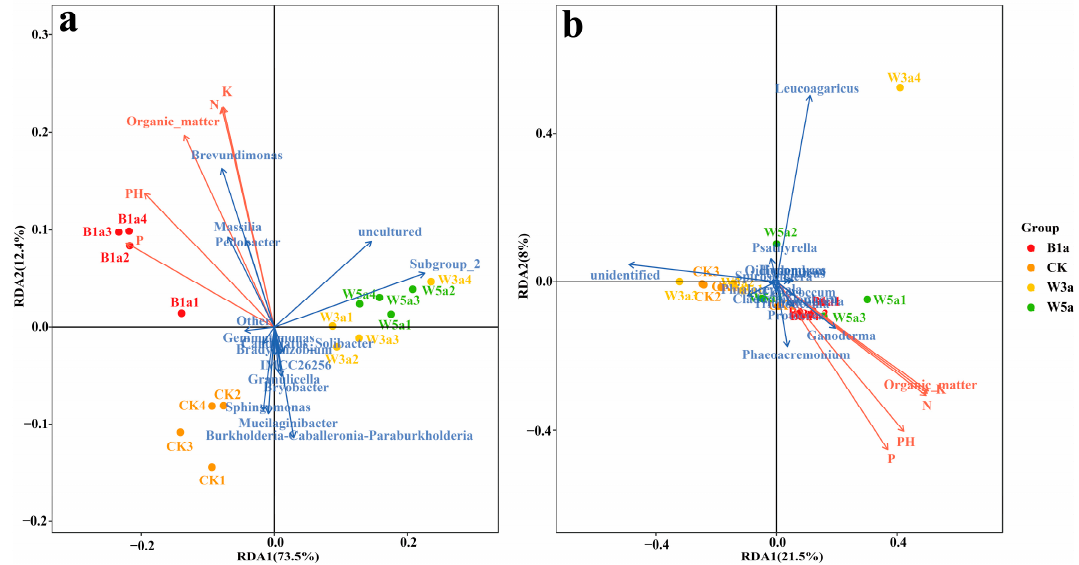
Figure 8. RDA relationship between soil bacteria ( a ) and fungi ( b ) with soil physicochemistry.